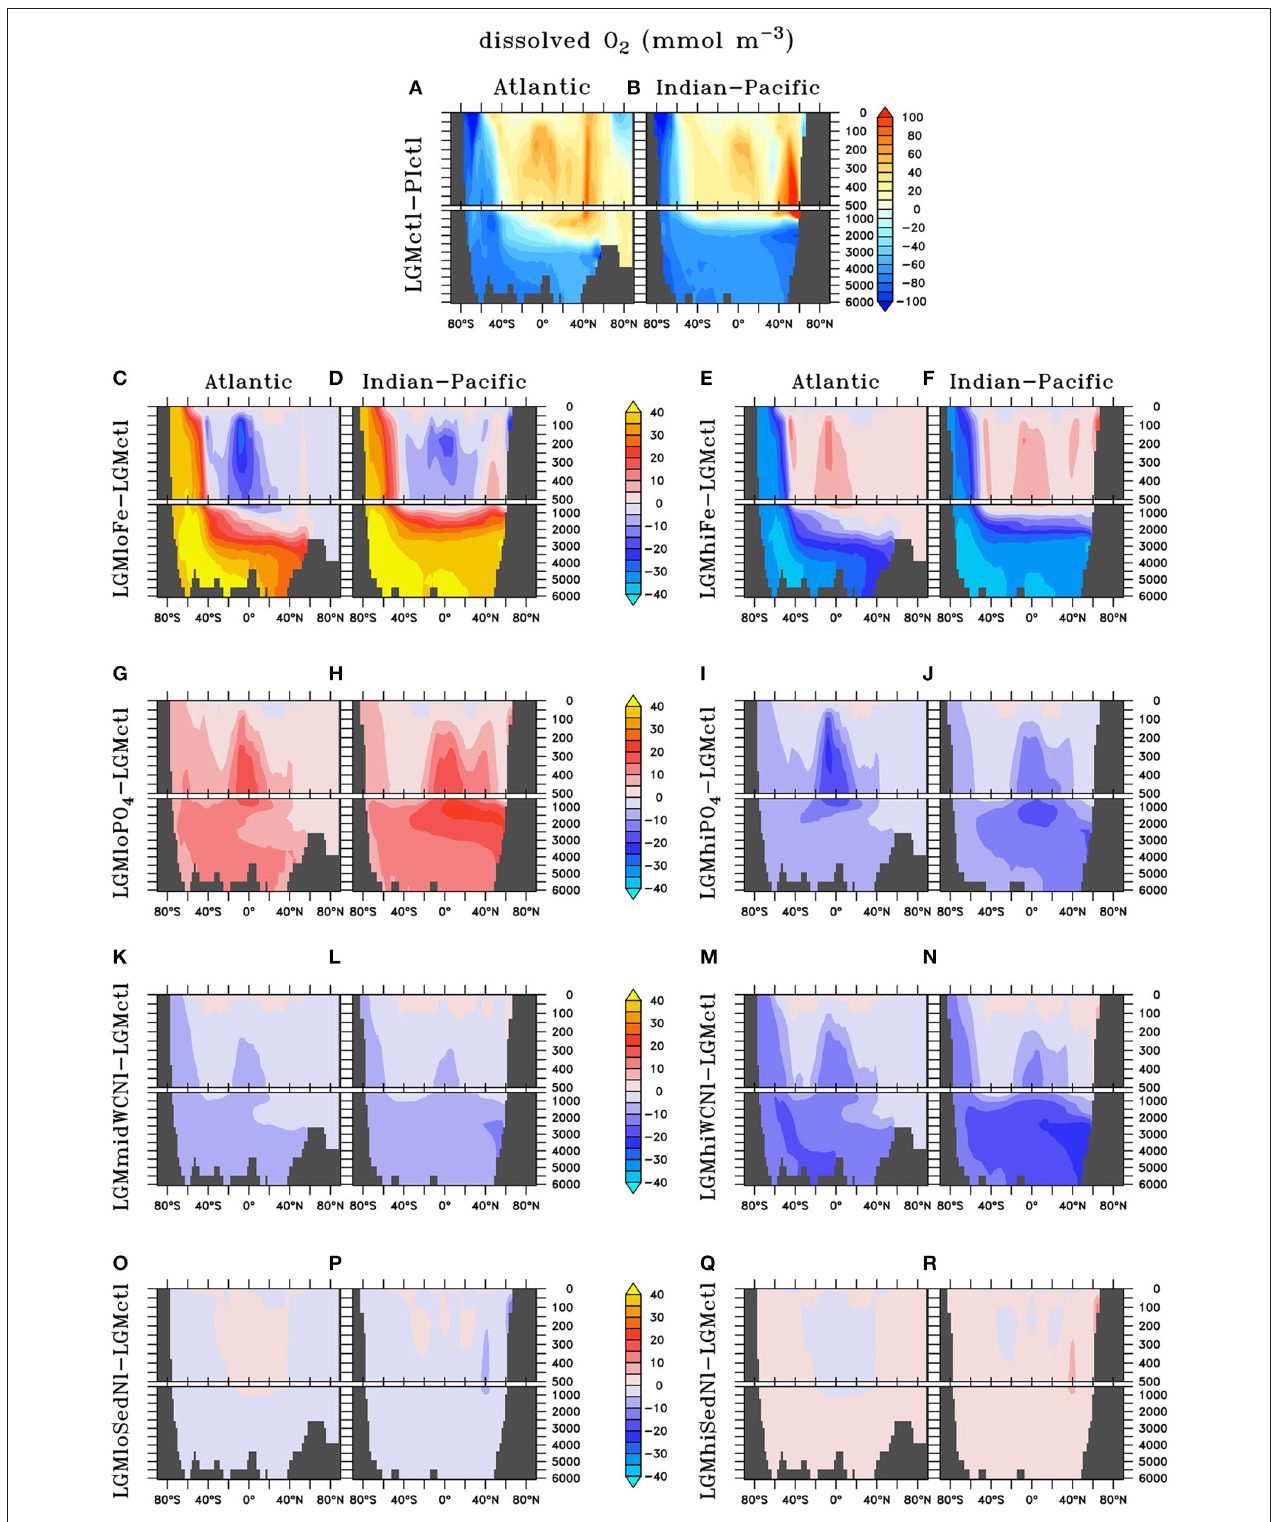
FIGURE 4 | Zonal dissolved oxygen differences in the Atlantic and Indian-Pacific Oceans, respectively, of (A,B) Last glacial Maximum control (LGMctl) minus preindustrial control (PIctl) and the Last Glacial Maximum simulations minus LGM control: (C,D) LGMloFe, (E,F) LGMhiFe, (G,H) LGMloPO 3 − 4 , (I,J) LGMhiPO 3 − 4 , (K,L) LGMmidWCNl, (M,N) LGMhiWCNl, (O,P) LGMloSedNl, and (Q,R) LGMhiSedNl.